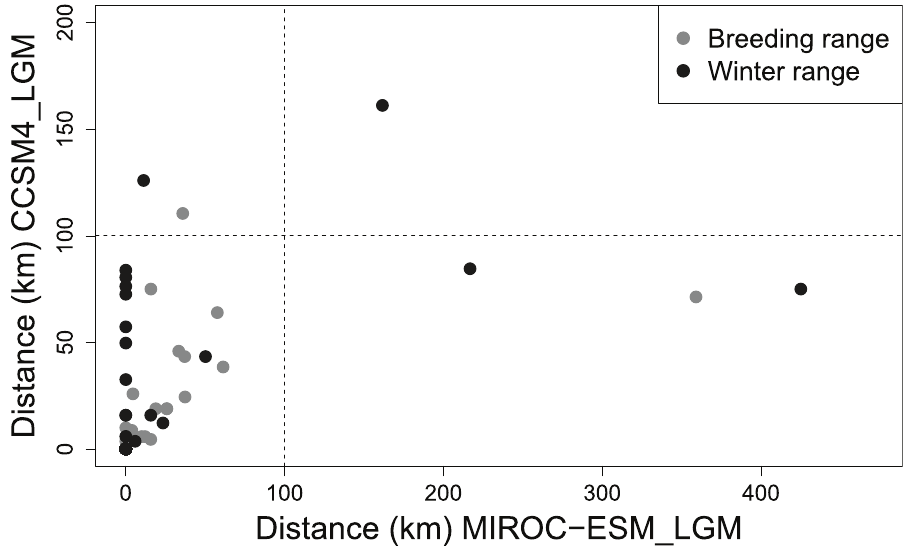
Fig 5. Plot of distances from La Brea to closest predicted occurrence under two different climatic conditions (CCSM4, MIROC-ESM) for 103 species of birds plotted as function of breeding or wintering ranges, showing only six species in which both analyses fail to predict occurrence within 100 km. The point at 150,160 is predicted by both analyses not to occur (verdin in winter) and hence is not in conflict. The two sets of predictions are significantly correlated (Pearson correlation = 0.50, P <